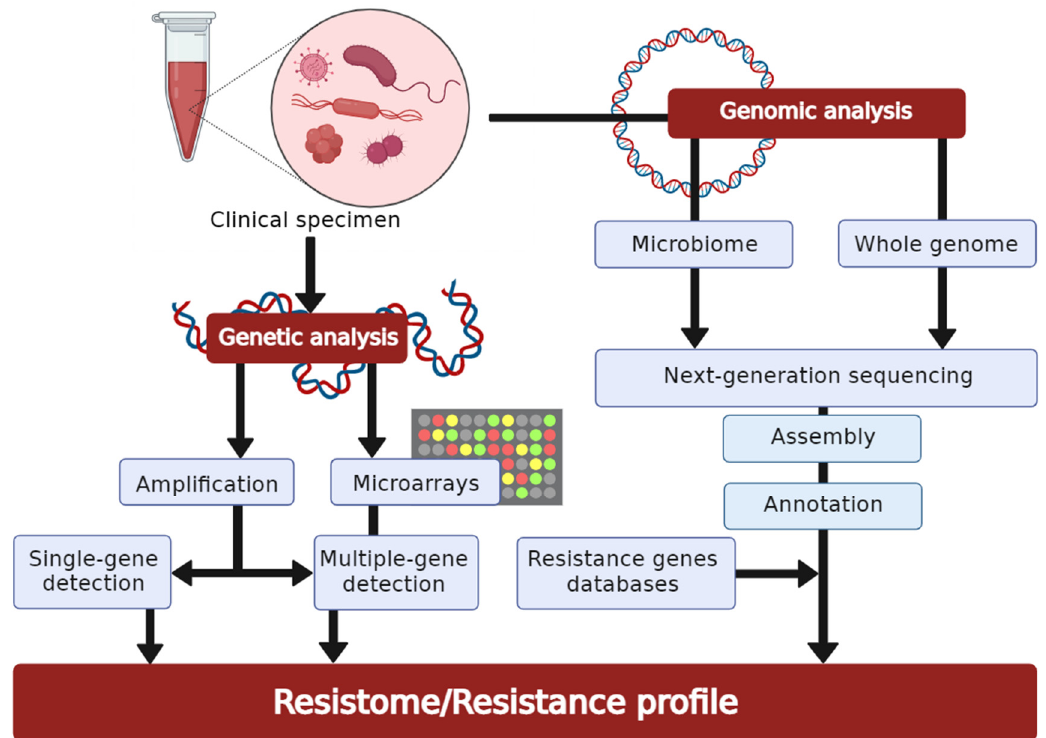
Figure 3. The basic workflow of molecular-based techniques for antimicrobial susceptibility testing. The routes from a clinical specimen to a final result are indicated by arrows (created with BioRender.com, accessed on 27 February 2022. Reproduction of this figure requires permission from